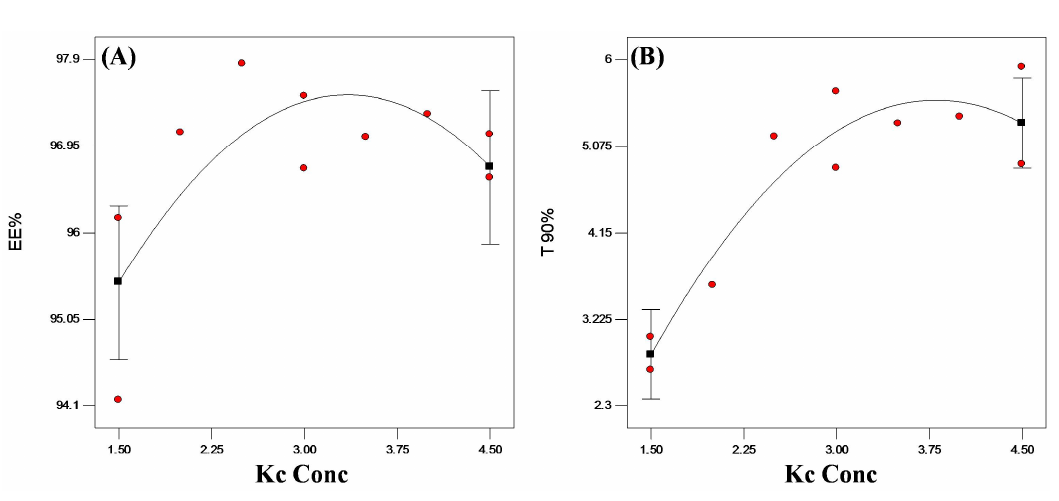
Figure 6. Statistical plot for the main effects of Kc concentration on ( A ) EE% and ( B ) t 90% of VP from VP-loaded Ch/Kc-PEC-based beads.